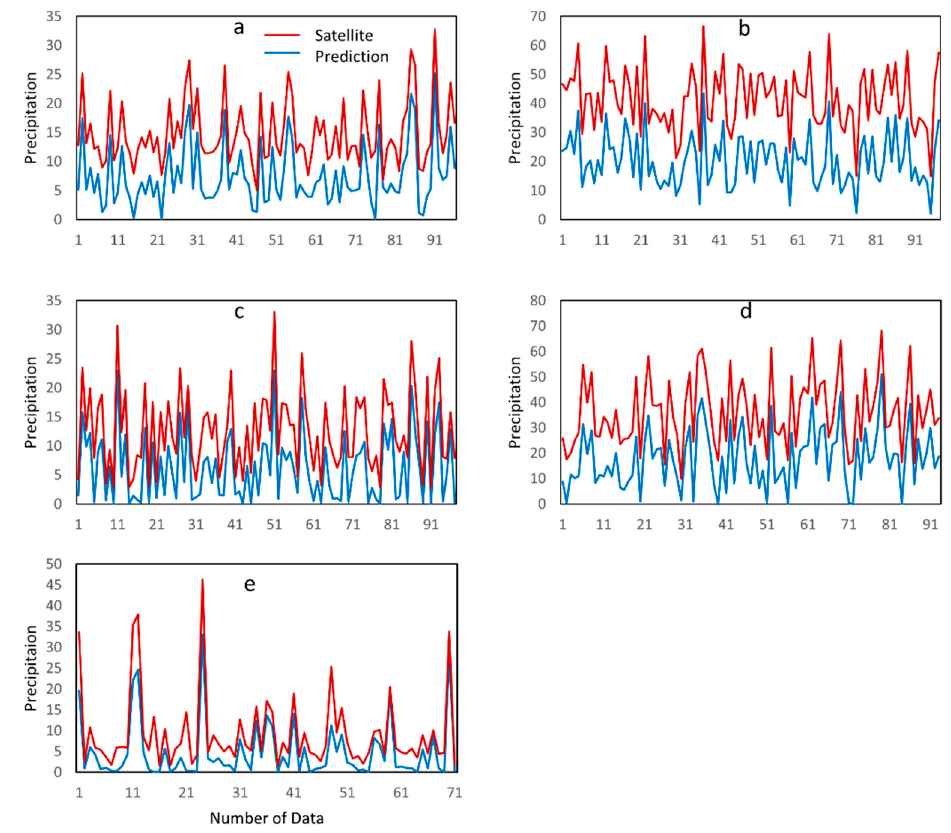
Figure 7. ICA predicted precipitation of the five events over Northeast Austria for ( a ) 17 April 2015, ( b ) 23 May 2015, ( c ) 3 September 2015, ( d ) 25 September 2015, and ( e ) 7 October 2015.